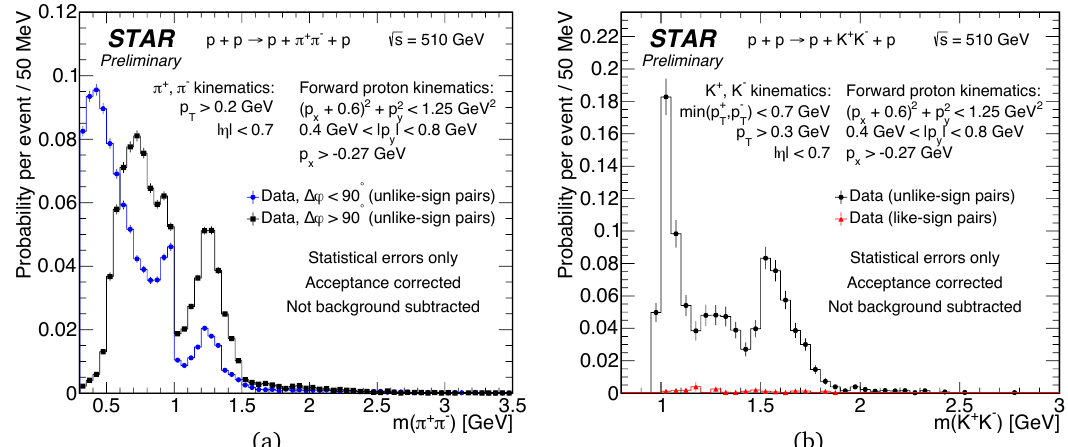
Figure 5: Uncorrected preliminary distributions of the invariant mass of (a) π + π − and (b) K + K − pairs, produced in the CEP process at the fiducial region explained on the plots. Error bars represent the statistical un- certainties. Figure (a) shows data separately for ∆ ϕ < 90 ◦ (blue) and ∆ ϕ > 90 ◦